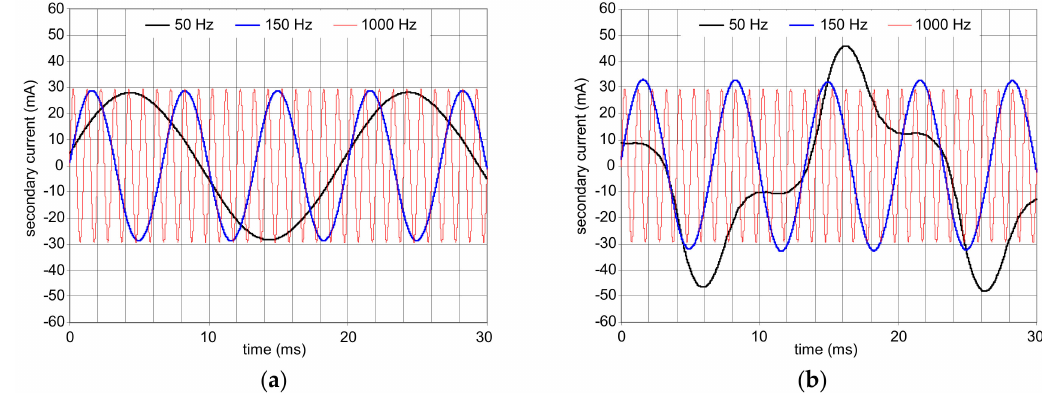
Figure 17. Results of the computer simulations of the secondary current ( i s in Figure 2) flowing through the electromechanical relay: ( a ) No serial capacitor in the secondary circuit; ( b ) serial capacitor in secondary circuit is applied; values of the residual current frequency: 50, 150, and 1000 Hz